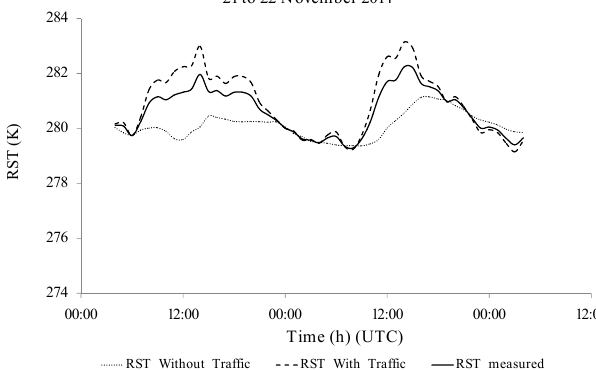
Figure 7. Assessment of the magnitude of traffic impacts on the RST, and illustration of a weighted average temperature of the road surface for the first